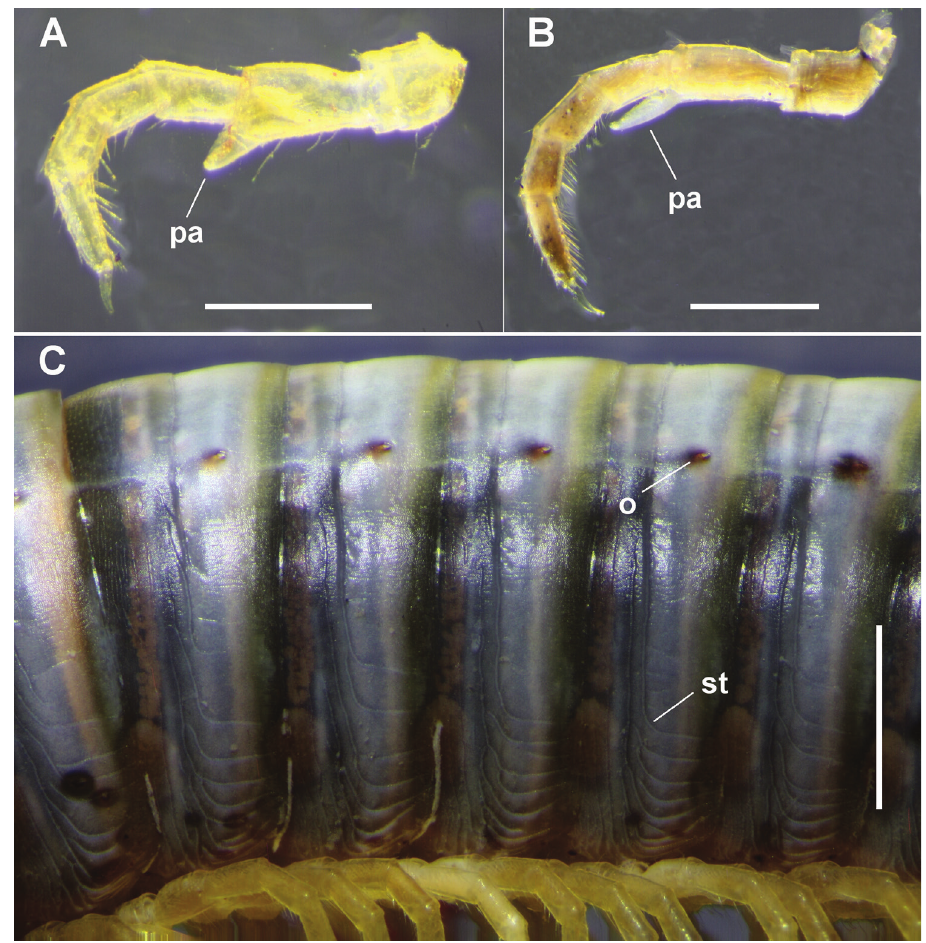
Figure 5. A, B Male midbody leg of A Amastigogonus tasmanianus (Chamberlin, 1920), ex QVM 23:54344 and B A. fossuliger Verhoeff, 1944, ex QVM 23:54468, showing prefemoral pad (pa) C Amastigogonus hardyi (Chamberlin, 1920), male ex TMAG J5897, left lateral view of rings at ca 2/3 body length, showing position of topmost horizontal stria (st) relative to ozopore (o). Scale bars: A, B = 0.5 mm, C = 1.0